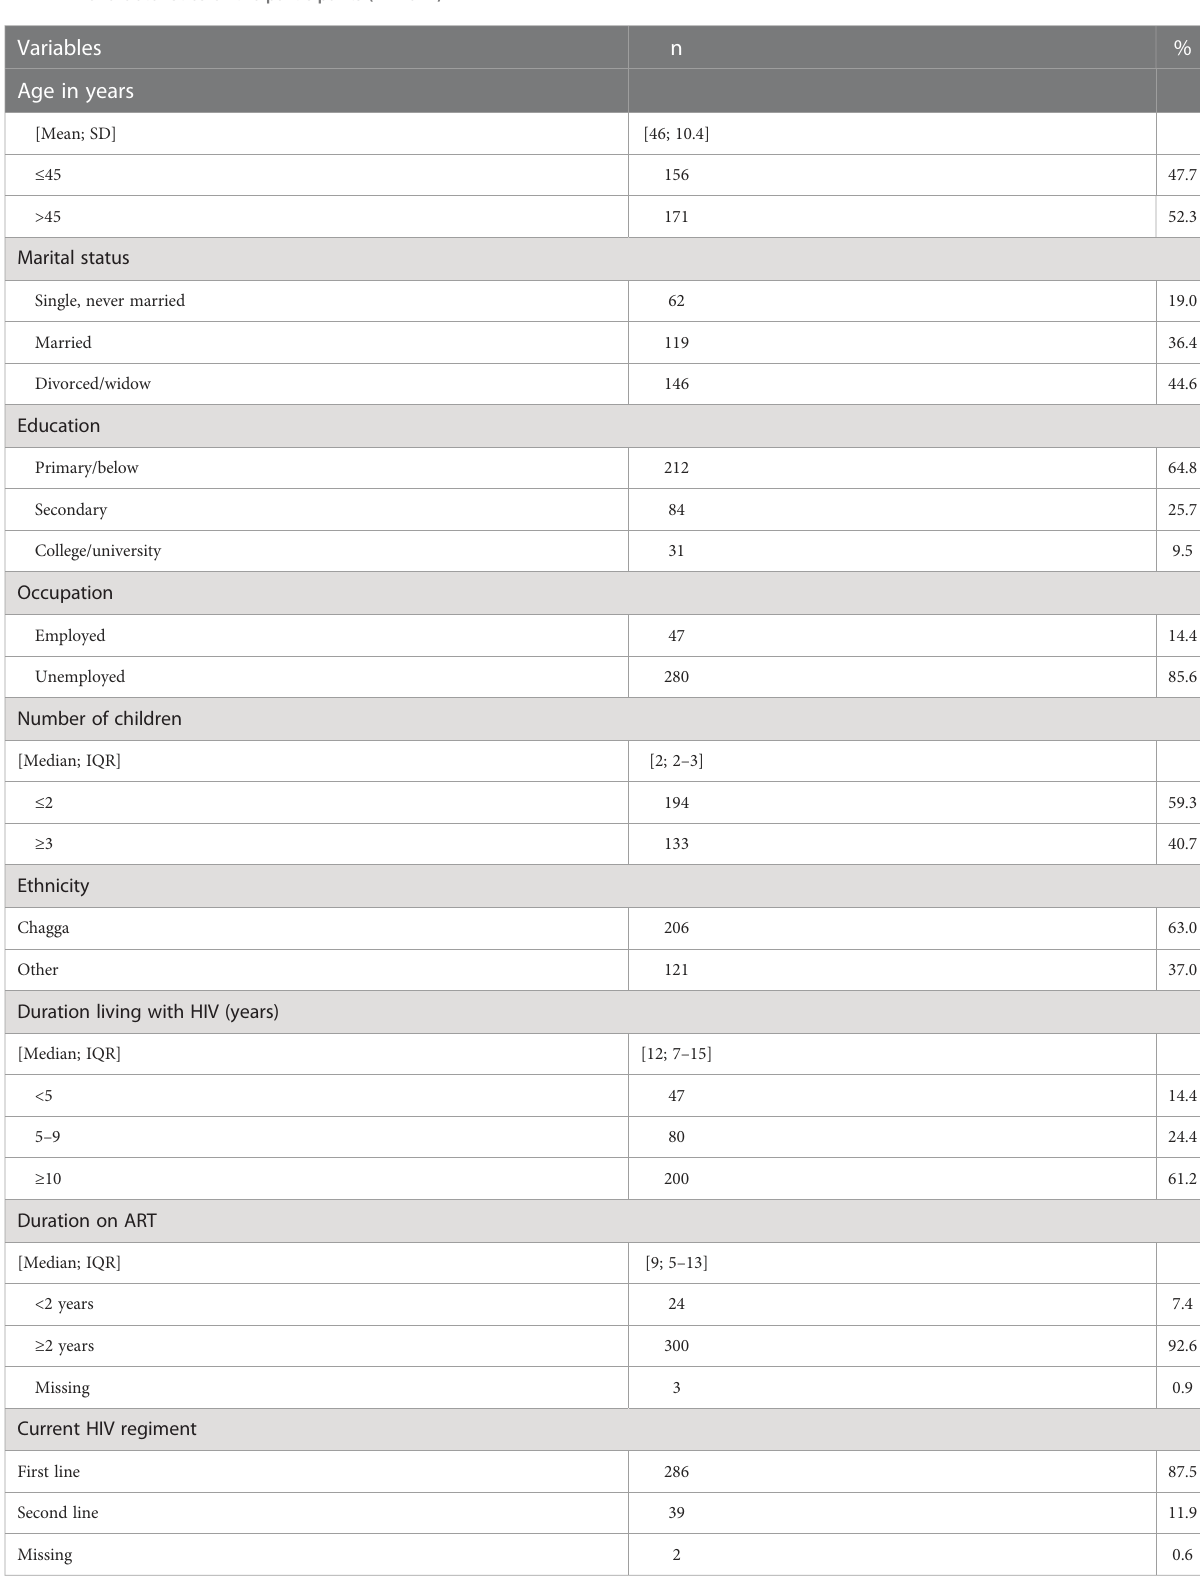
TABLE 1 Characteristics of the participants ( N =